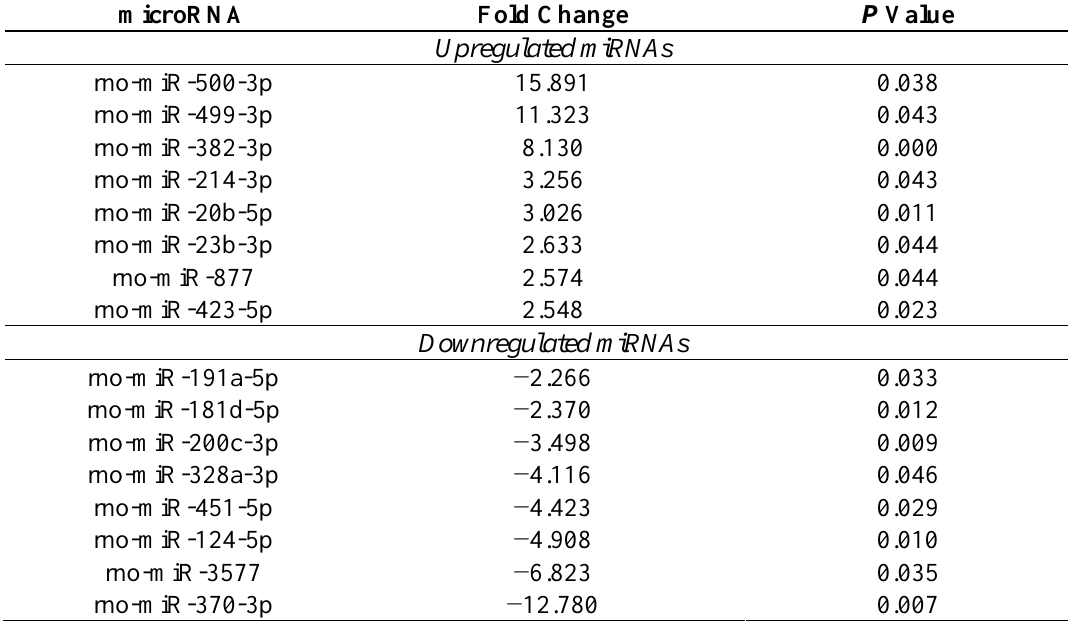
Table 3. Differentially expressed microRNAs between the Rhizoma Dioscoreae extract treatment group (RDE) and ovariectomized group